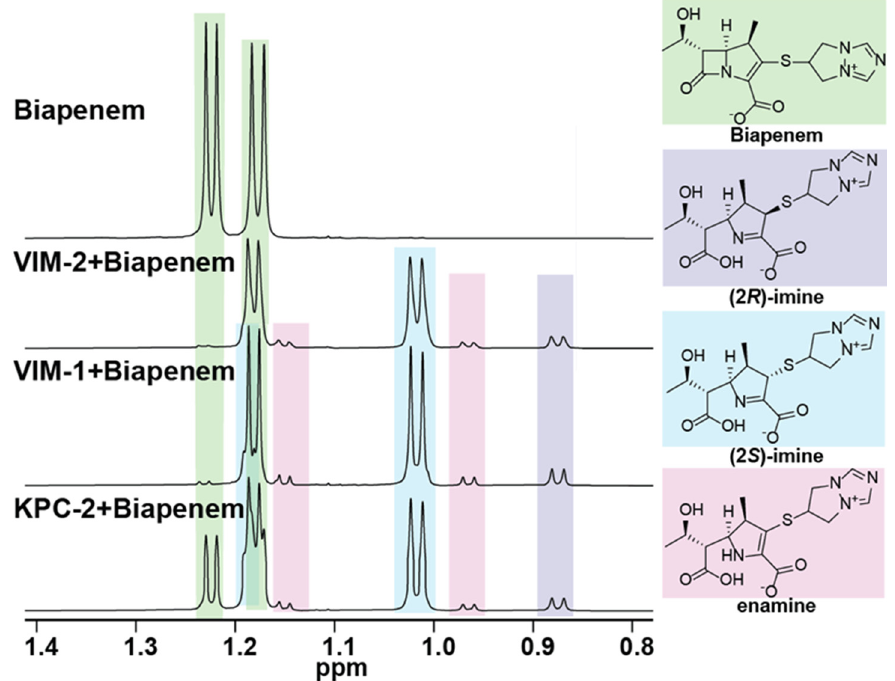
Figure 2. High-field regions of 1 H NMR spectra (600 MHz) for reaction of biapenem with the MBLs VIM-1 or VIM-2, or the SBL KPC-2. Biapenem (5 mM, green) was treated with the purified β -lactamase (280 nM, 30 min) in 50 mM of sodium phosphate at pH 7.6 (with 10% v/v D 2 O). Formation of enamine (pink) and (2 R )-imine and (2 S )-imine (purple and blue, respectively) products was observed in